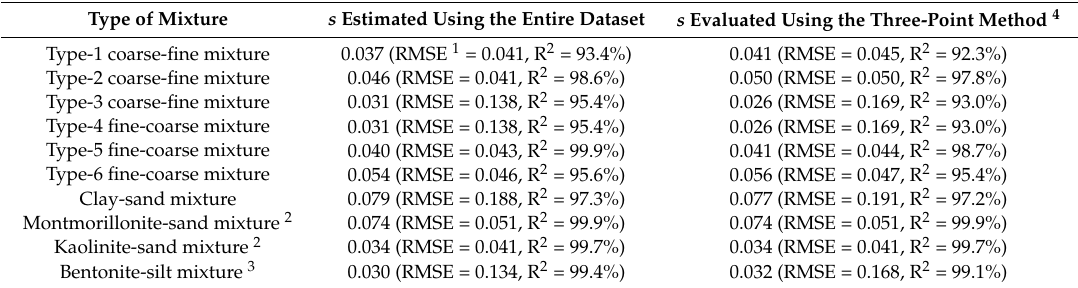
Table 1. Summary of the scaling factor ( s ) values estimated for all the samples tested in this study and literature-derived experimental datasets.